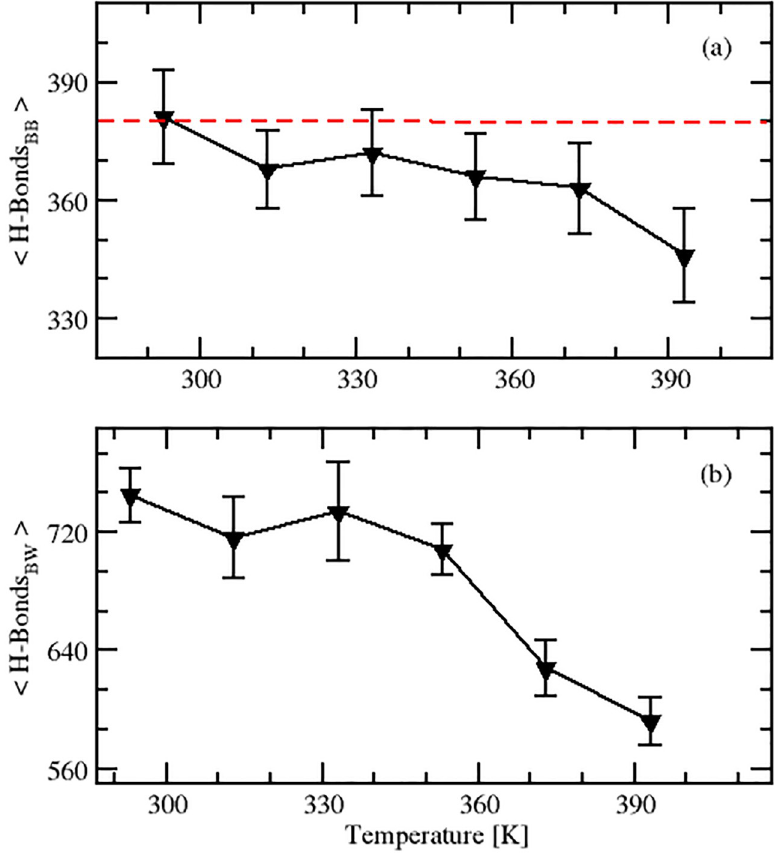
Fig 2. Average number of backbone-backbone and backbone-water H-bonds in SazCA. Analysis of effect of temperature on the number of backbone-backbone and backbone-water H-bonds in SazCA. The variation of average number of backbone-backbone H-bonds with temperature is shown in (a) and the variation of number of backbone- water H-bonds with temperature is shown in (b). The dashed red line in plot (a) represents the number of H-bonds present in the protein crystal